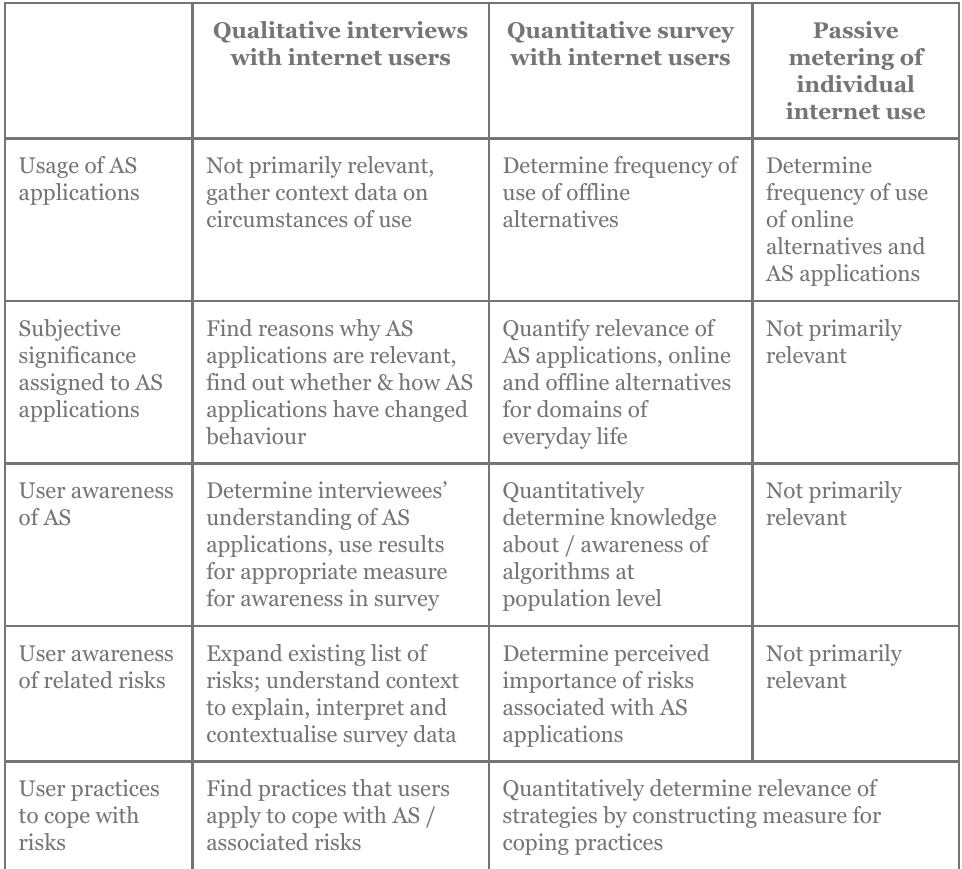
Table 2: Expected contributions of the three methods to the empirical assessment of